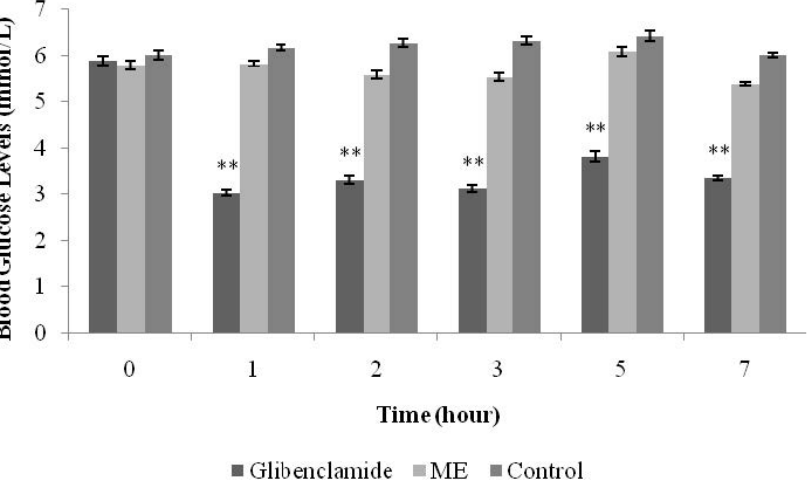
Figure 2. Effects of the methanolic extract (ME) of S. polyanthum leaf, and glibenclamide on blood glucose levels of normal rats. Values are expressed as mean ± standard error of the mean (SEM) ( n = 6); ** p < 0.01 compared with the control group. Figure 3 shows the IPGTT test in normal rats. The increase in BGLs upon glucose loading was not significantly altered by oral treatment with ME (1 g/kg), within 120 min after glucose loading. p < 0.05,